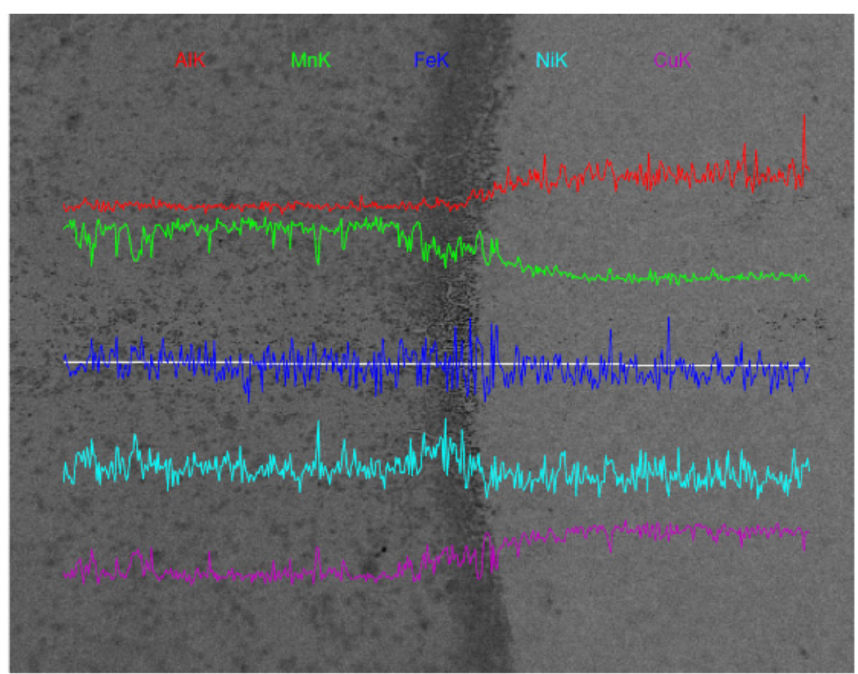
Figure 6. Changes in element concentrations from M2052 to NAB across the interface, as measured by energy-dispersive spectroscopy.